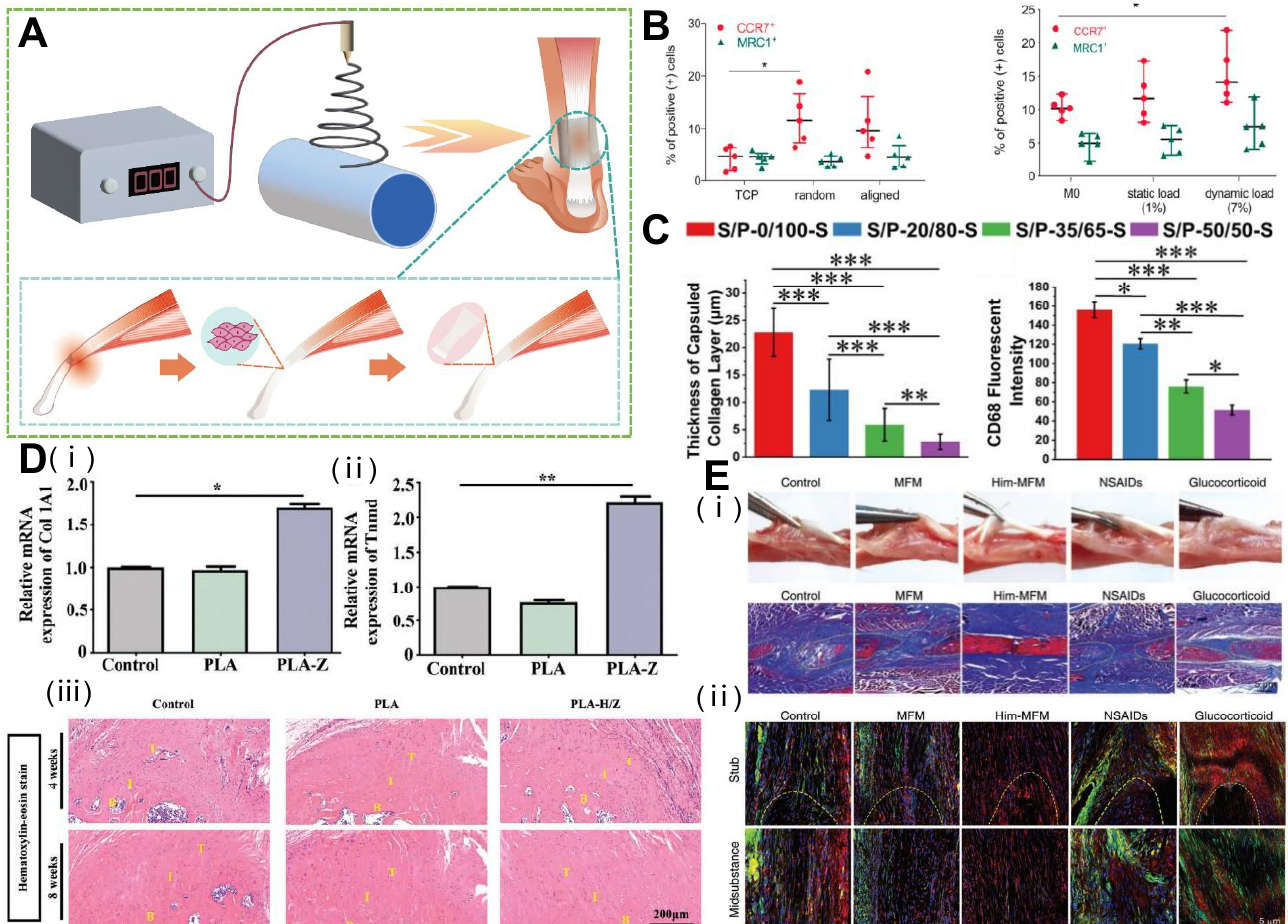
Figure 4. Electrospinning 3D structure used in different stages of tendon repair. ( A ) Application of electrospinning products in different stages of tendon repair. ( B ) Disorganized substrate topogra- phy and dynamic mechanical loading drive macrophage polarization toward a pro-inflammatory phenotype in vitro. (* p < 0.05). Reprinted with permission from Ref. [114]. Copyright 2020 Elsevier Inc. ( C ) Inflammatory response of different SF/PLLA nanoyarn-based woven fabrics 14 days after subcutaneous implantation. (* p < 0.05, ** p < 0.001, *** p < 0.0001). Reprinted with permission from Ref. [58]. Copyright 2022 Elsevier Inc. ( D ) MOF-based bipolar metal flexible electrospun fiber membrane increases tendon cell proliferation and maturation. (B: bone; I: interface; T: tendon; * p < 0.05, ** p < 0.01). Reprinted with permission from Ref. [119]. Copyright 2022 Wiley-VCH GmbH. ( E ) The Him-MFM promoted endogenous recovery of tendon and reduced adverse adhesion and scarring. Reprinted with permission from Ref. [122]. Copyright 2022 Wiley-VCH